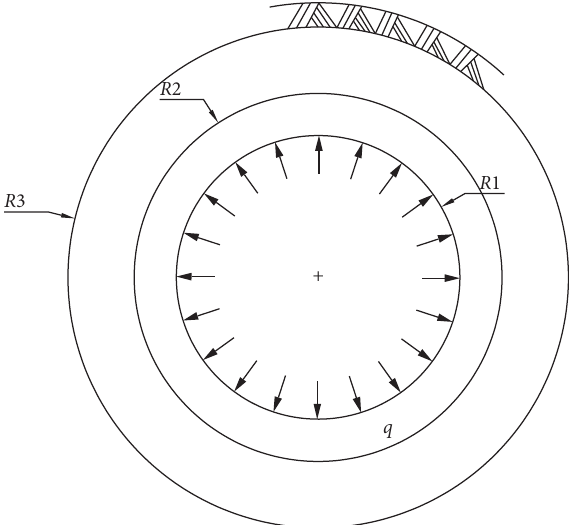
Figure 1: Double cylinder model embedded in an infinite